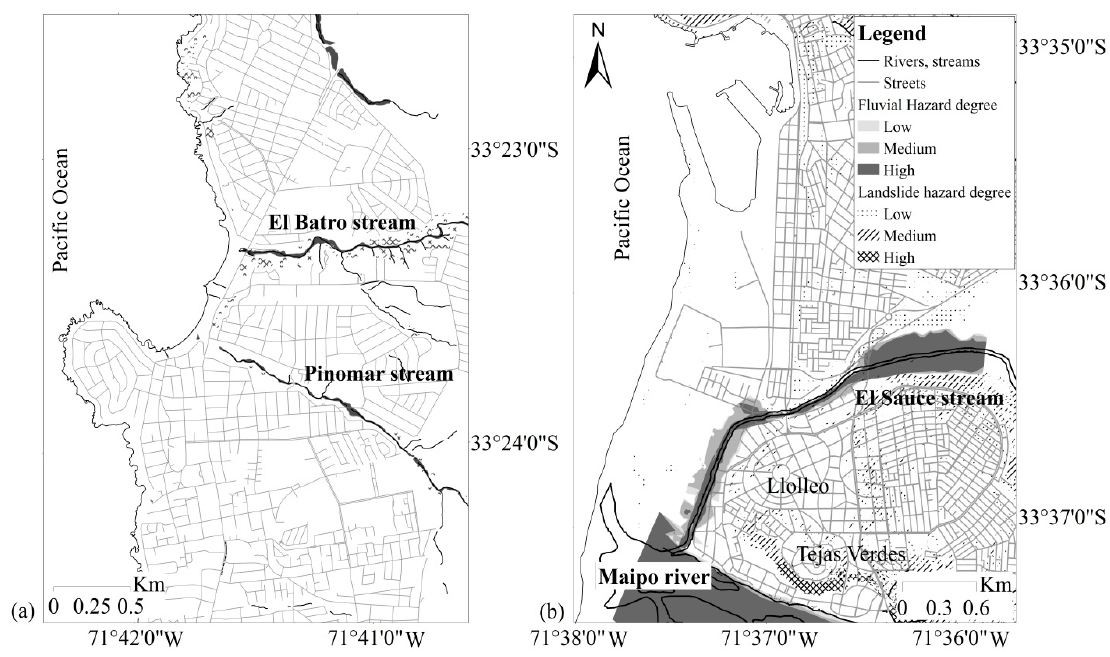
Figure 6. Integrated degree of hazard due to fluvial flood inundations and landslides triggered by 10-, 20-, 25-, and 50-year rainfall at ( a ) El Quisco and ( b ) San Antonio. San Antonio is more likely to be affected by landslides than El Quisco (Figure 6a,b). Landslide